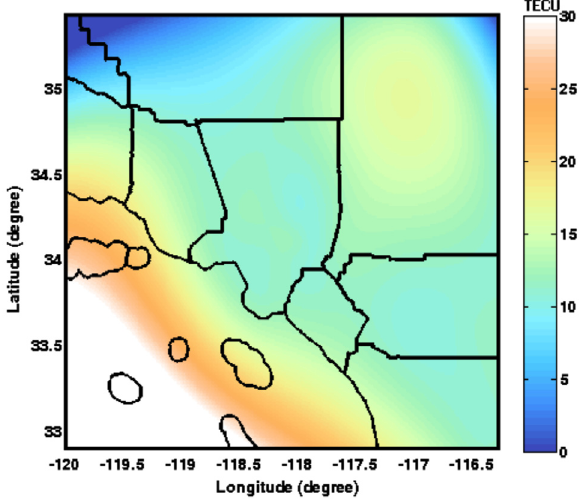
Figure 3. 2-D VTEC model for 25.08.2012, 07:45:00 (UT) RMSE= 0.70